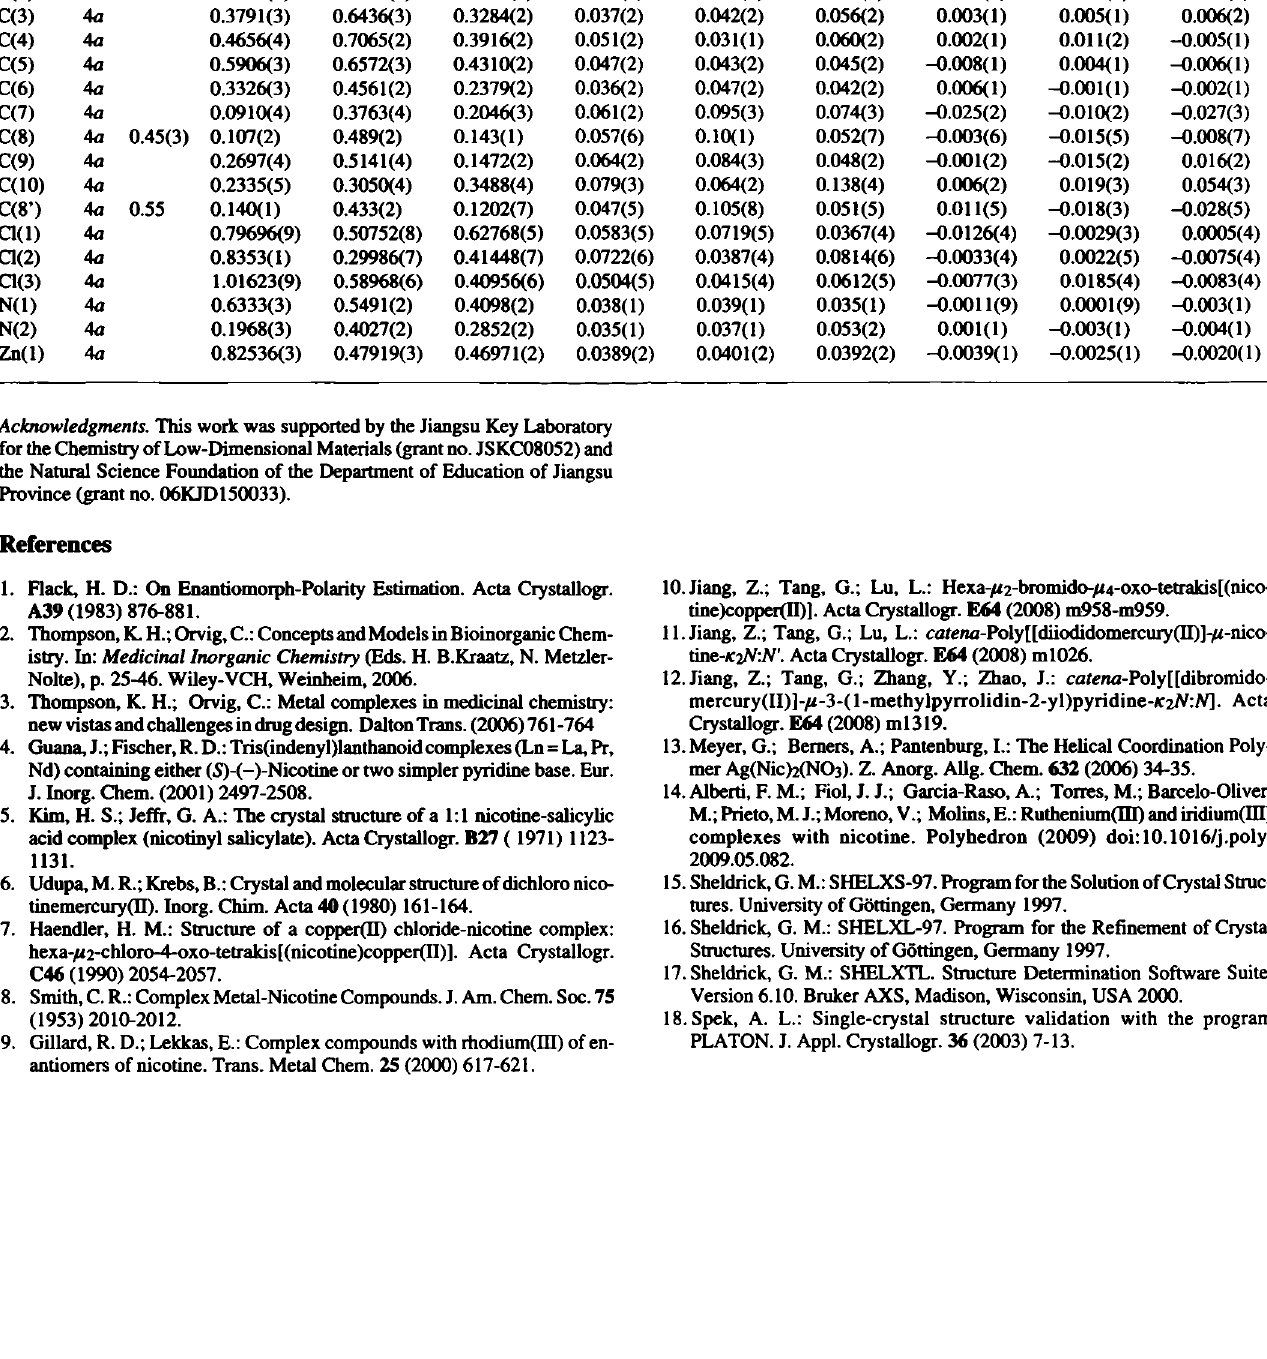
Table 3. Atomic coordinates and displacement parameters (in Ä 2